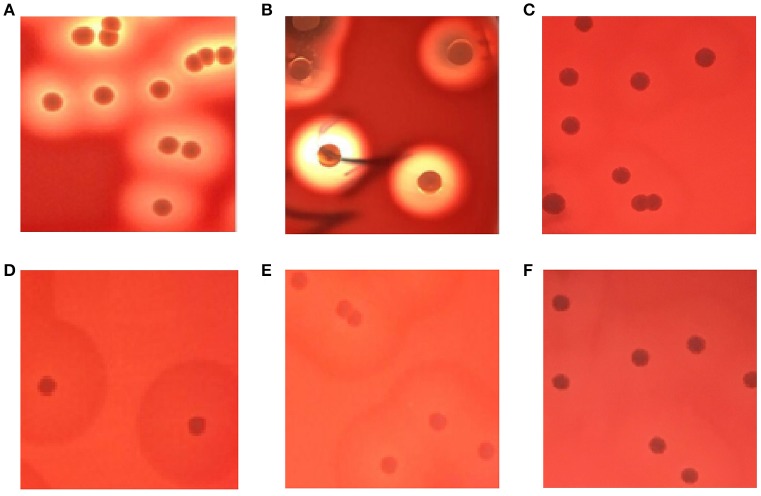
Hemolytic phenotype comparative analyses of S. aureus in blood agar plates. (A) control strain S. aureus ATCC25923; (B) SCHP; (C) SIHP(growing in the microaerophilic condition); (D) SIHP(growing in the aerobic condition); (E) SIHP(growing in the anaerobic condition); (F) SIHP after 10 passages.